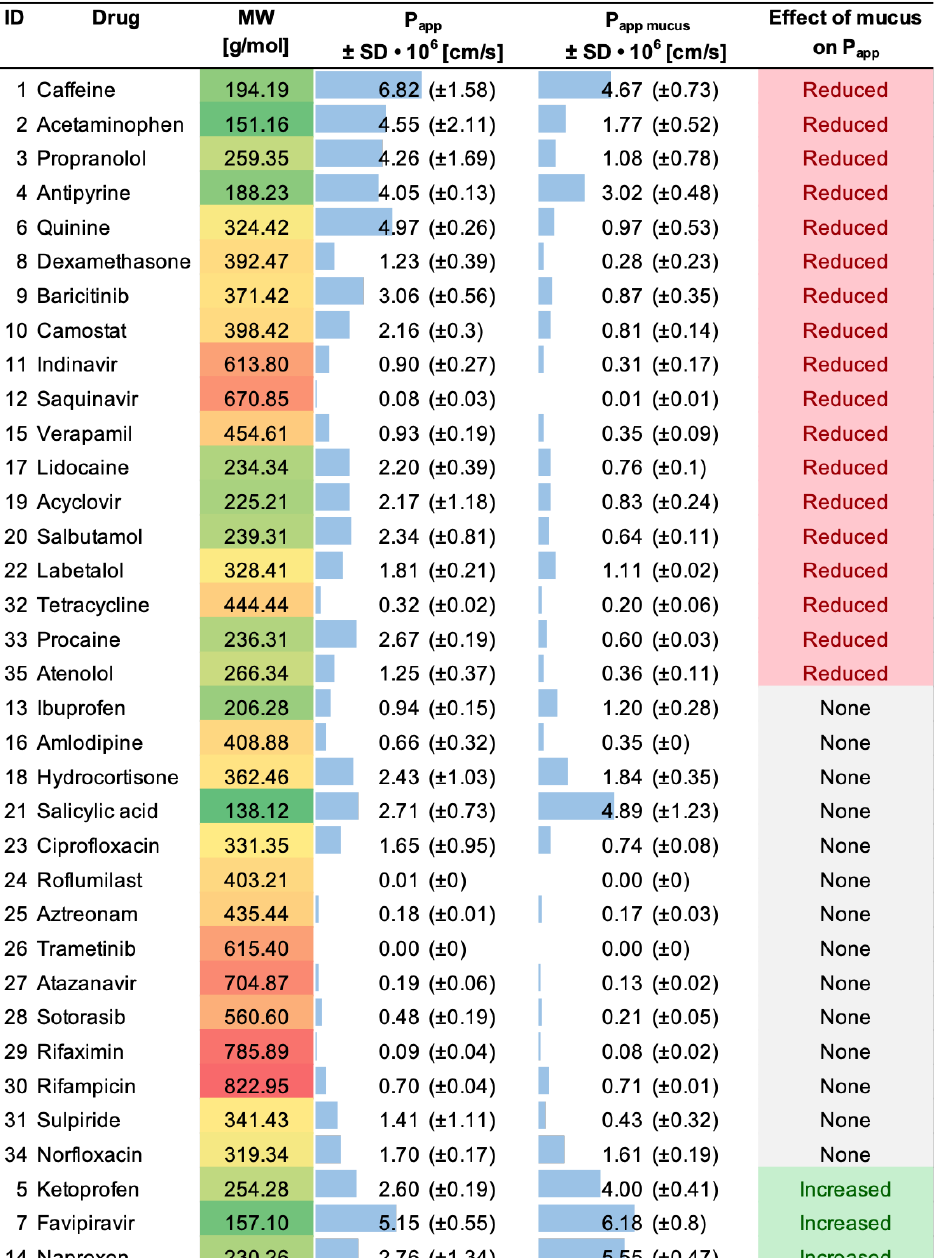
Table 1. Summary of the apparent permeabilities recorded on PermeaPad in the absence ( P app ) and in the presence ( P app mucus ) of the mucus model. Student’s t -test was applied to test the